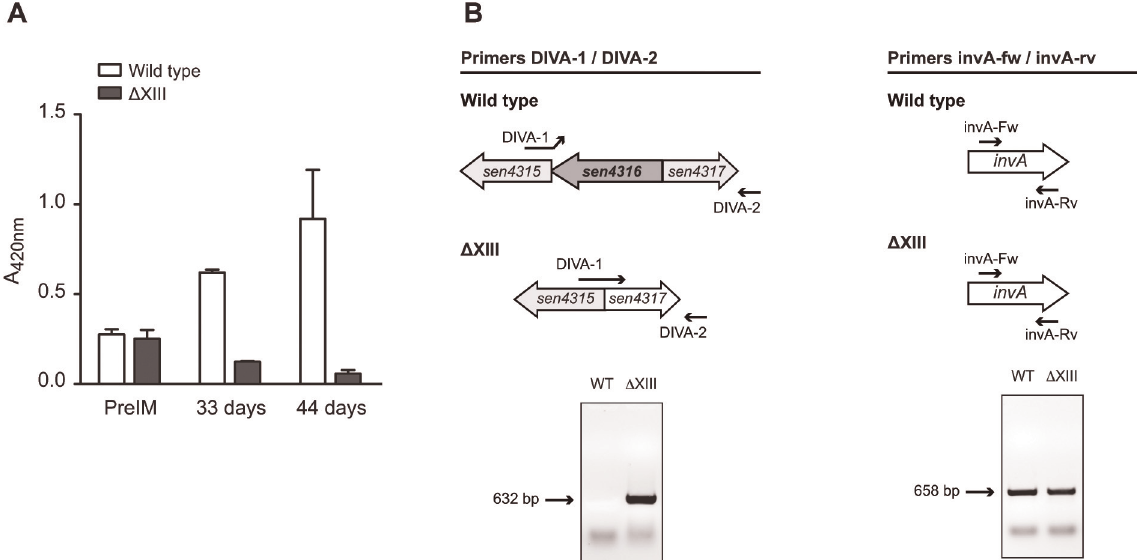
Fig 6. Δ XIII is a DIVA vaccine that allows differentiation of infected and vaccinated animals. (A) SEN4316 based ELISA of pooled sera from wild type and Δ XIII infected animals, obtained before infection (PreIM) and 33 and 44 days post infection. Sera from animals infected with the wild type strain and not with Δ XIII present antibodies against the SEN4316 protein. Error bars represent standard deviation between triplicate wells. (B) DNA from pooled faecal samples from wild type and Δ XIII infected animals, collected at day 1, 7, 14 and 21 post infection, were analyzed by PCR. Amplification of stool DNA with primers DIVA-1 and DIVA-2 allowed the identification of vaccinated animals with Δ XIII strain. Amplification with primers invA-fw and invA-rv served as a control of the presence of Salmonella DNA. Results shown are representative of results obtained throughout time, since Salmonella DNA was present in faecal samples since day one post